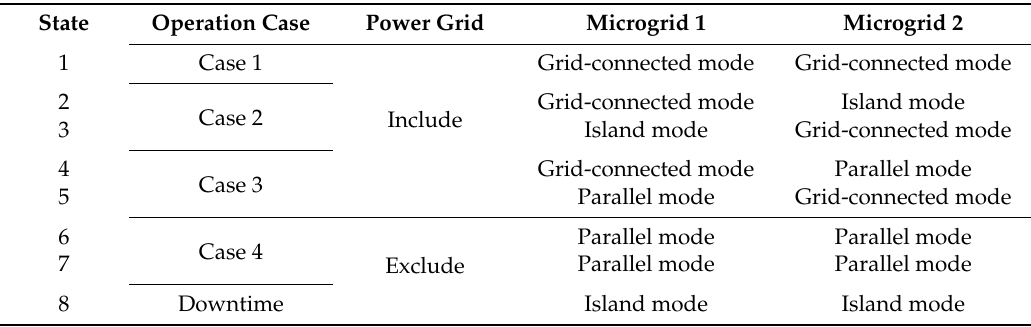
Table 3. All the states of the energy